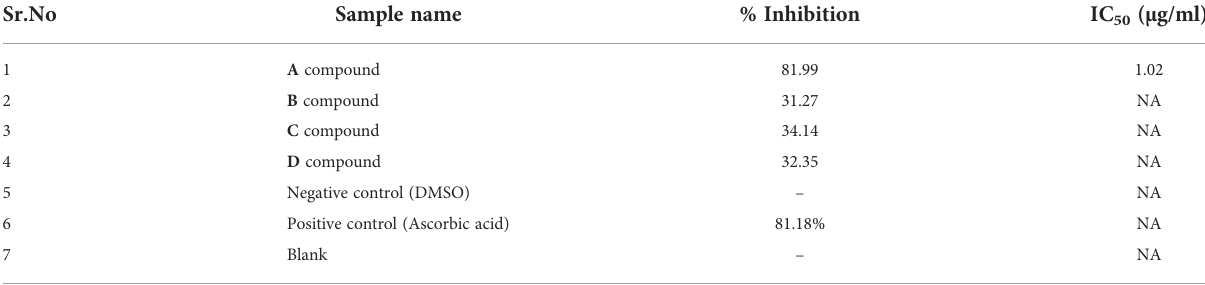
TABLE 1 Percentage inhibition and IC 50 of tested compounds using a -glucosidase inhibition assay.